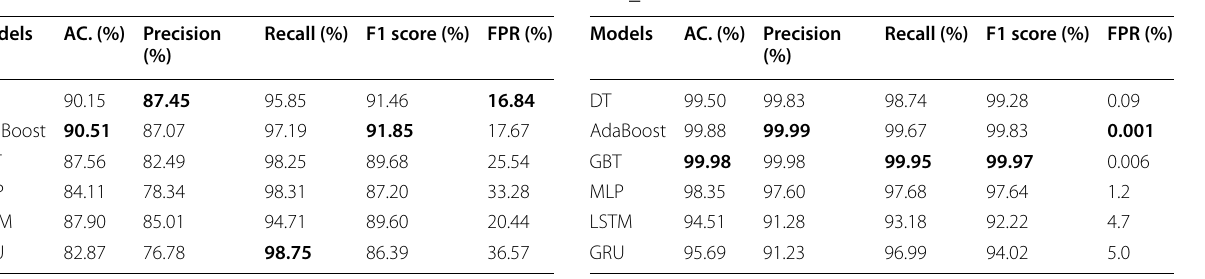
Table 7 Result of the models with all features (39) for Network